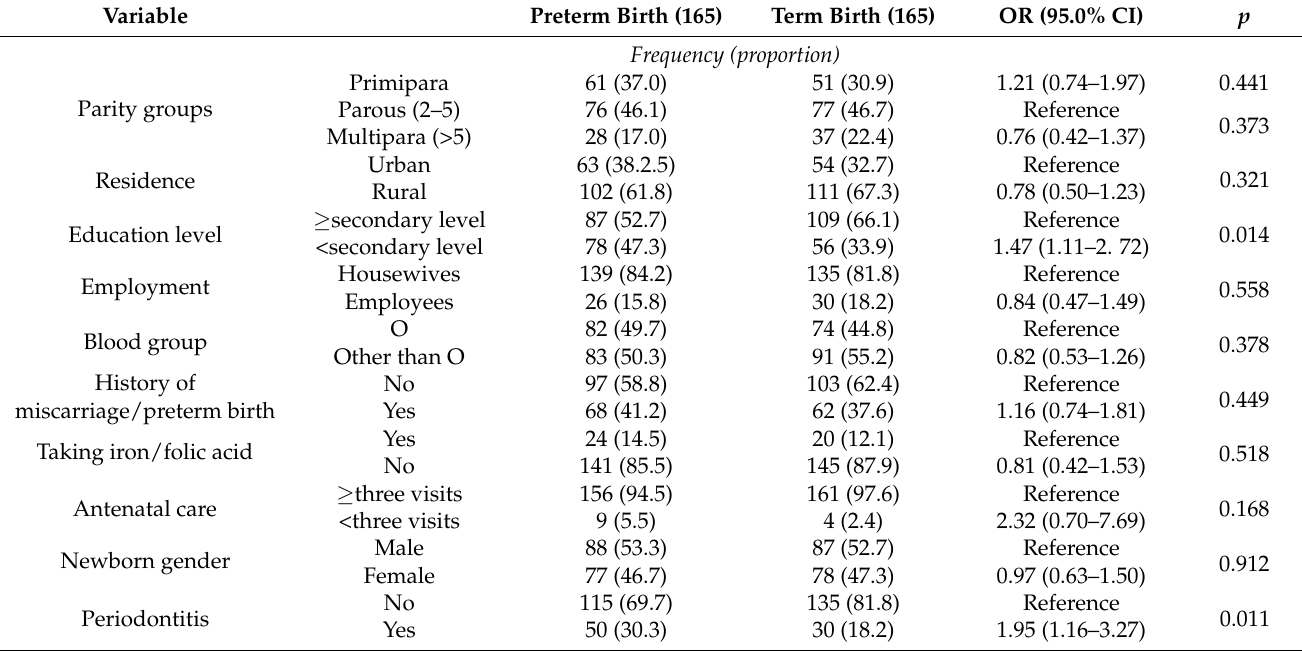
Table 2. Univariate analysis of the factors associated with preterm birth at Omdurman hospital in Sudan, 2021.